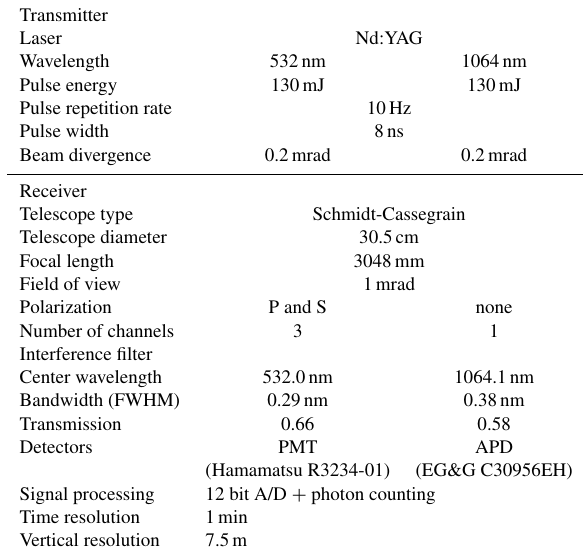
Table 1. Characteristics of Mie